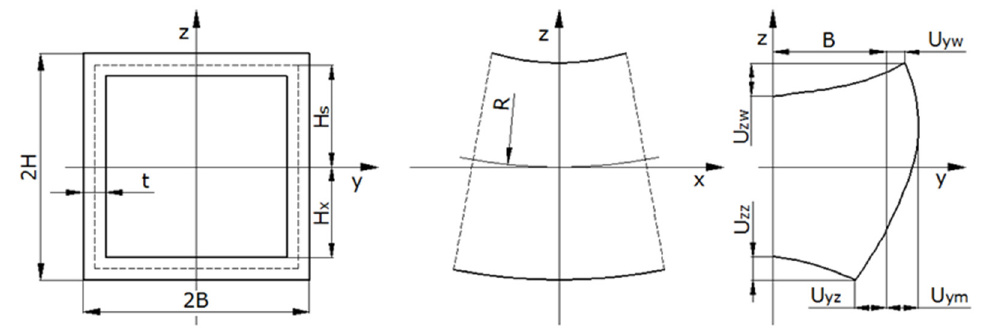
Figure 1. Characteristic tube dimensions and displacements of the deformed cross section [8].